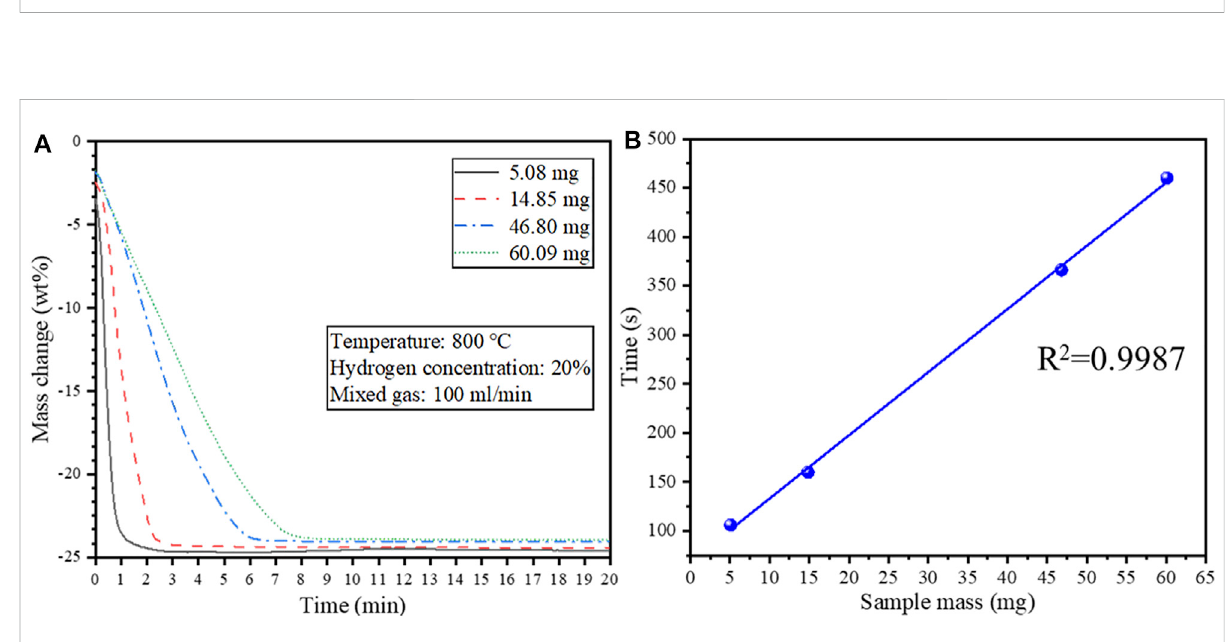
FIGURE 8 (A) Effectofsamplemassontheisothermalreductionbehaviorofthecathodematerialat800 ° C; (B) Therelationshipbetweenthetimerequired for complete reduction and the starting sample